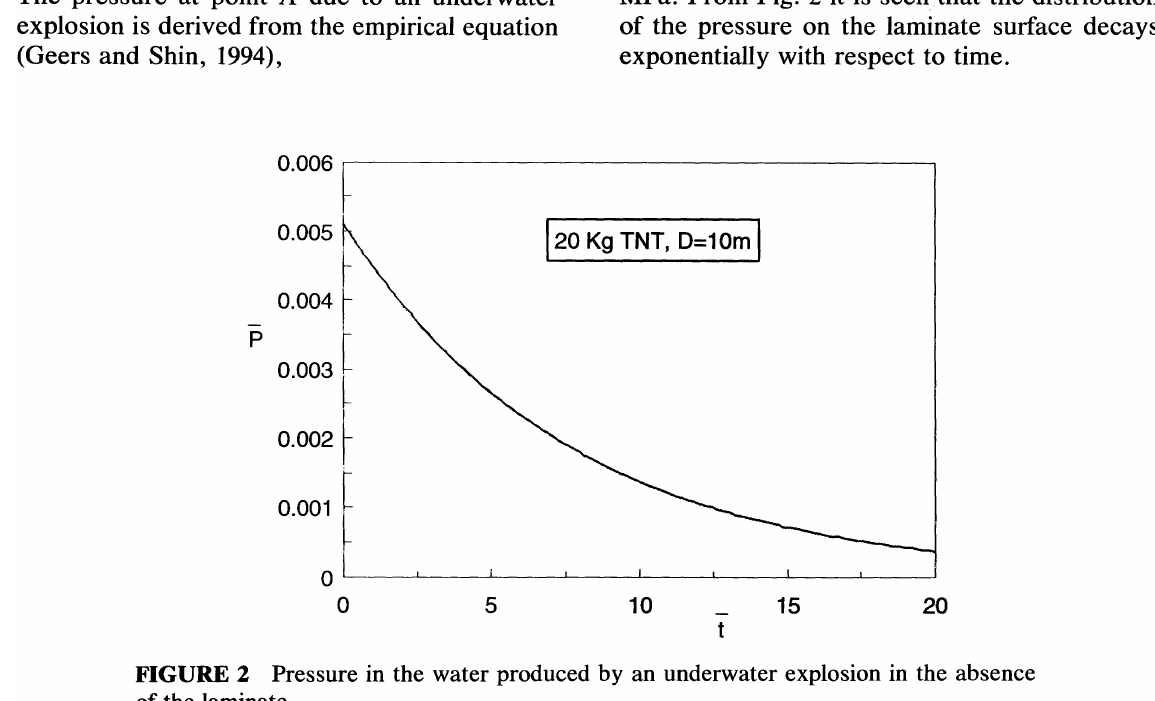
FIGURE 2 Pressure in the water produced by an underwater explosion in the absence of the